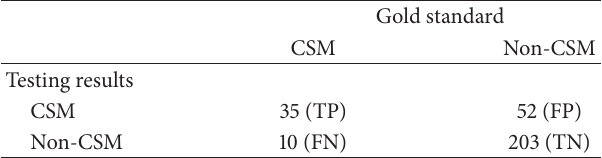
Table 4: Evaluation about CSM.